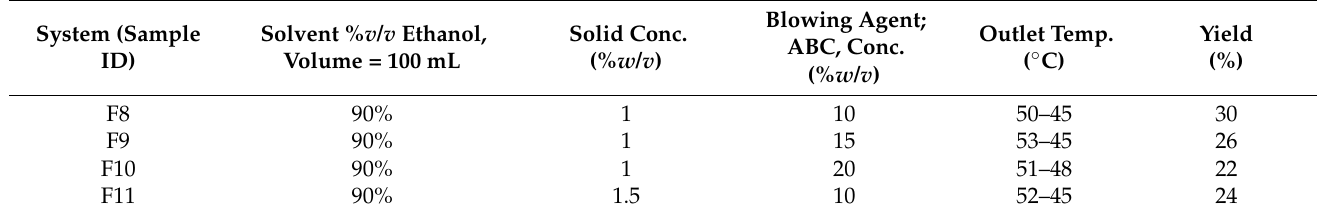
Table 3. Spray-drying parameters and input parameters for TAA spray-dried products with blowing agent *.